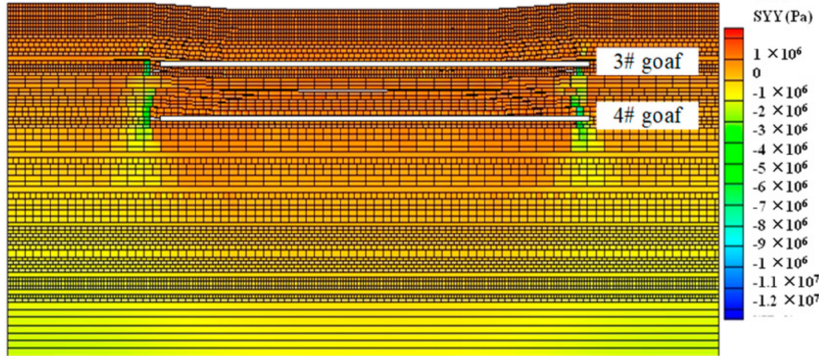
Figure 18. Stress field diagram of overburden after the mining of the 4# coal seam.